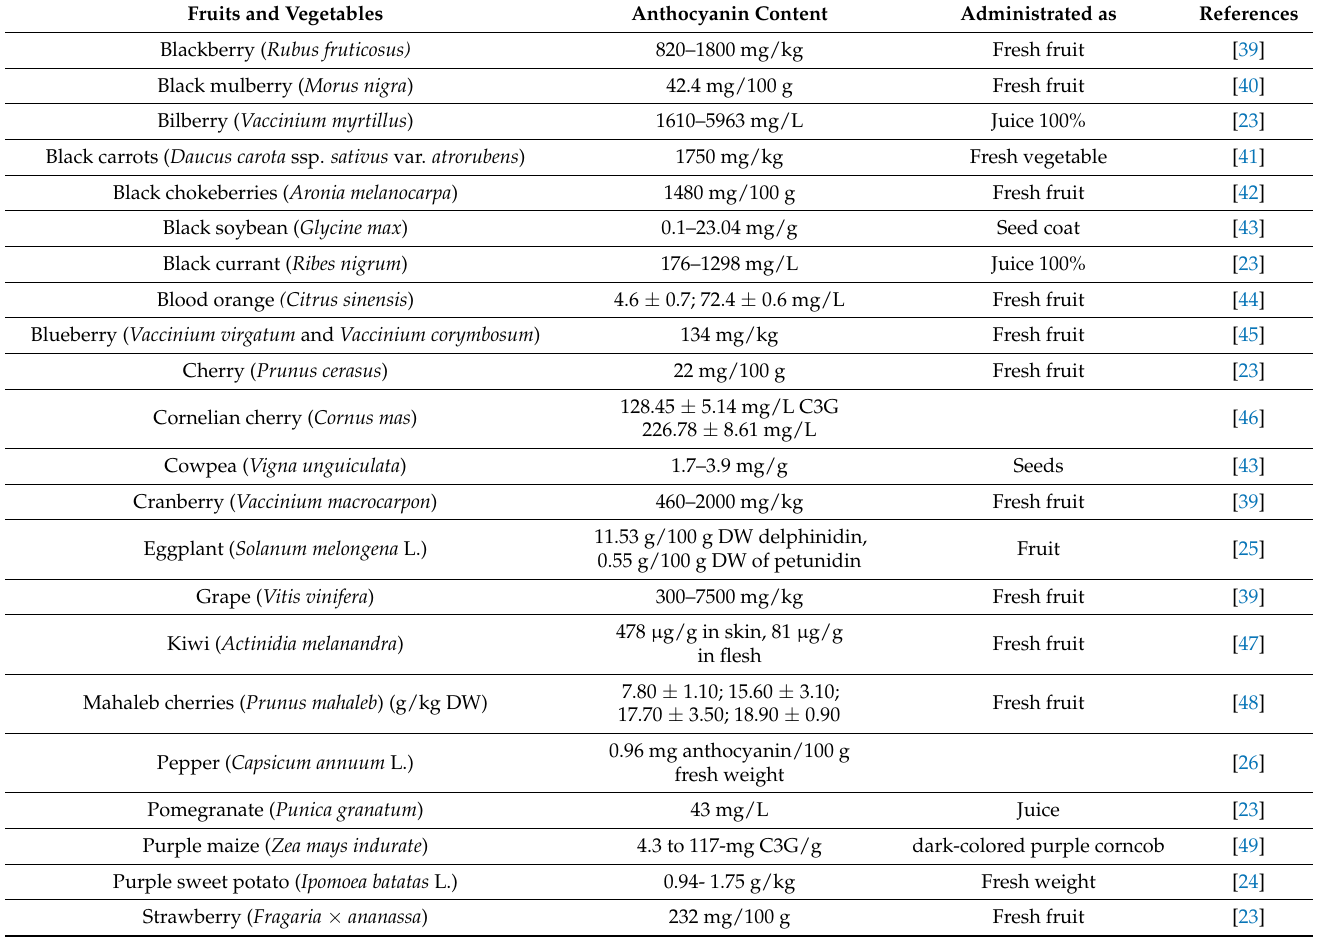
Table 1. Anthocyanin content of the fruits and vegetables mentioned in the